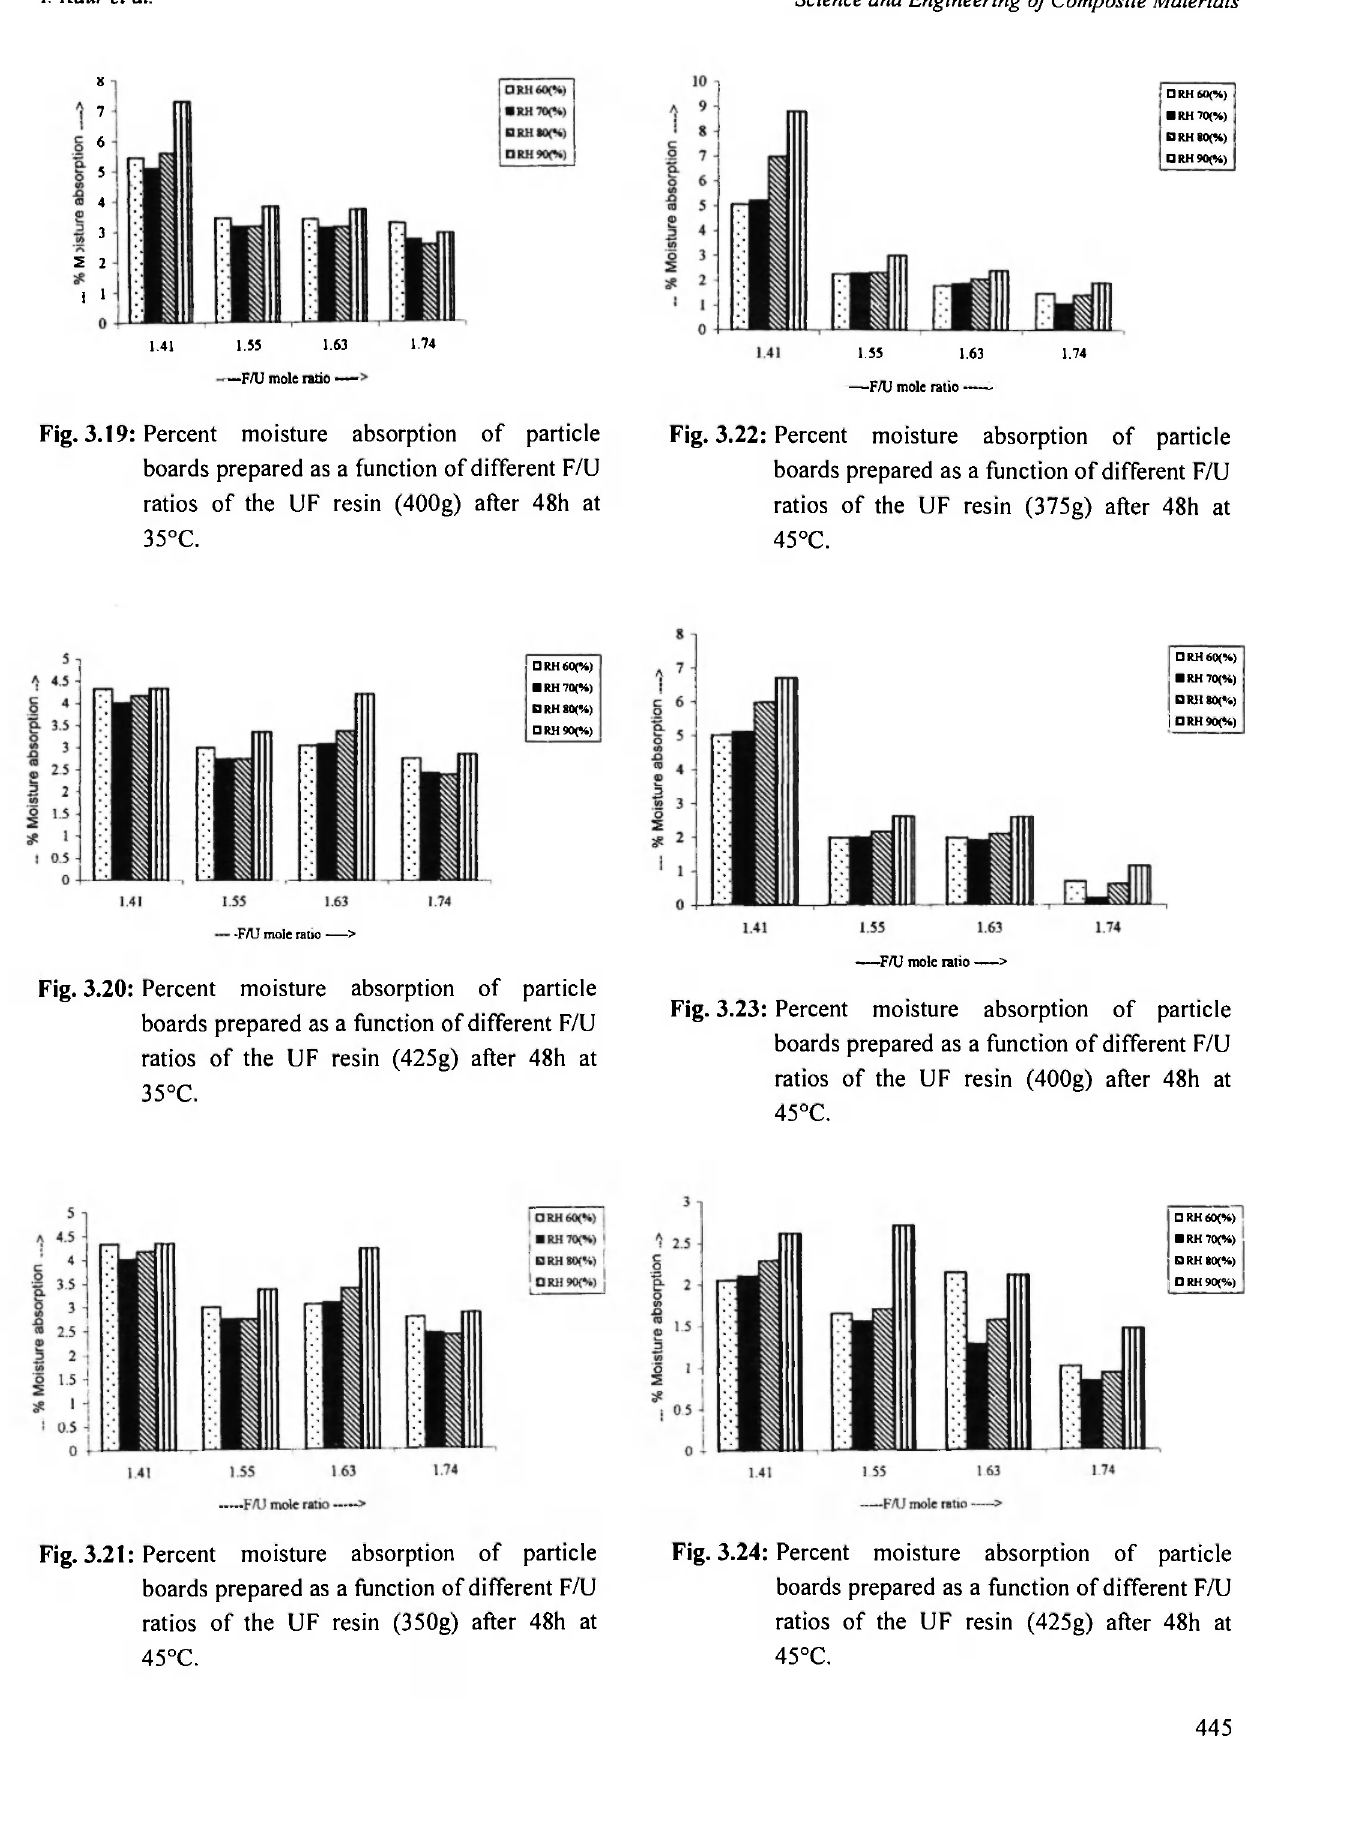
Fig. 3.21: Percent moisture absorption of particle boards prepared as a function of different F/U ratios of the UF resin (350g) after 48h at 45°C.